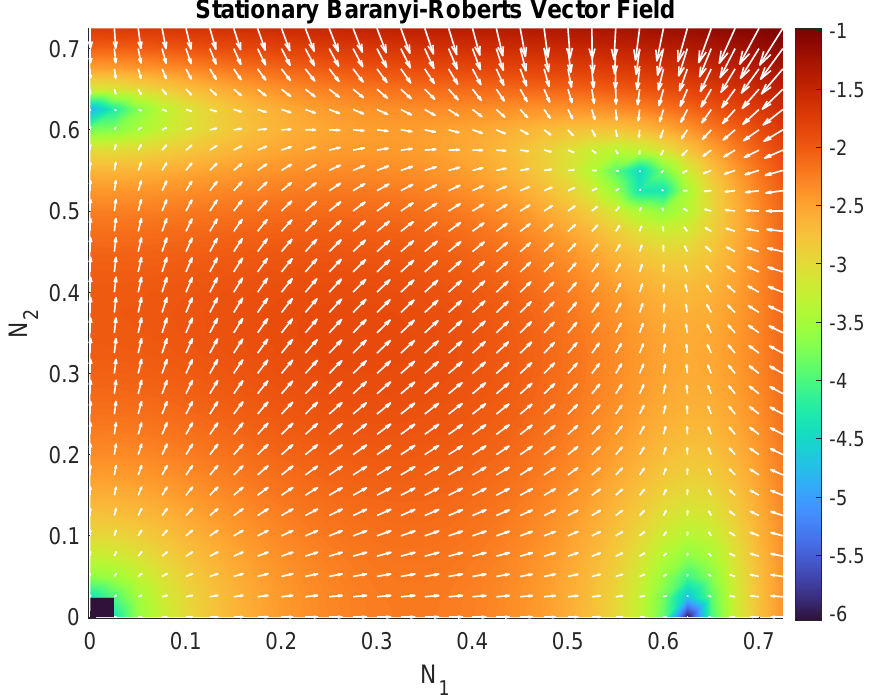
Figure 4. Flow function, g ( · ) , and its log-magnitude, log ( (cid:107) g ( · ) (cid:107) 2 ) , given by the Baranyi–Roberts system (9) and (10) and the optimized parameters in Table 3. In darker color the four equilibrium points given by the solutions of the nonlinear system (11) and